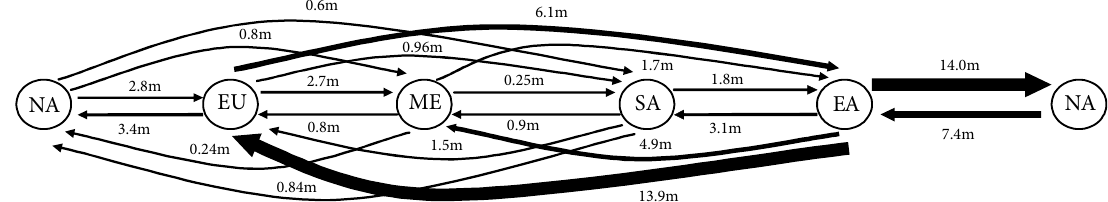
Figure 9. The East–West shipping flows (unit – TEUs; NA – North America; EU – Europe; ME – Middle East;